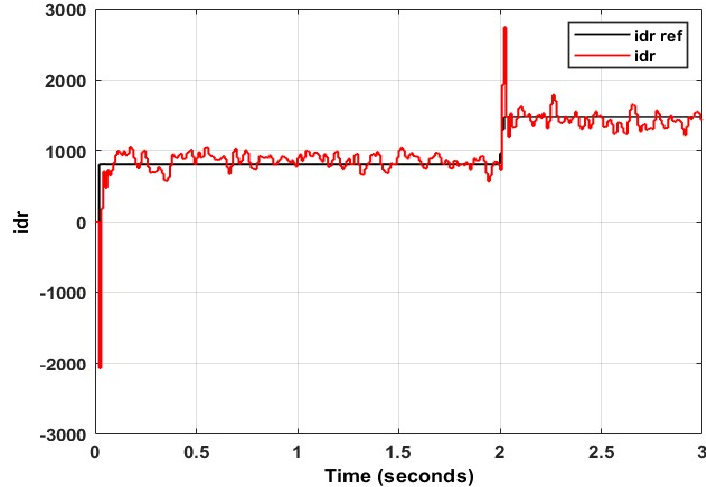
Figure 39. Rotor direct axis current ripple using DCI at 80% dip.